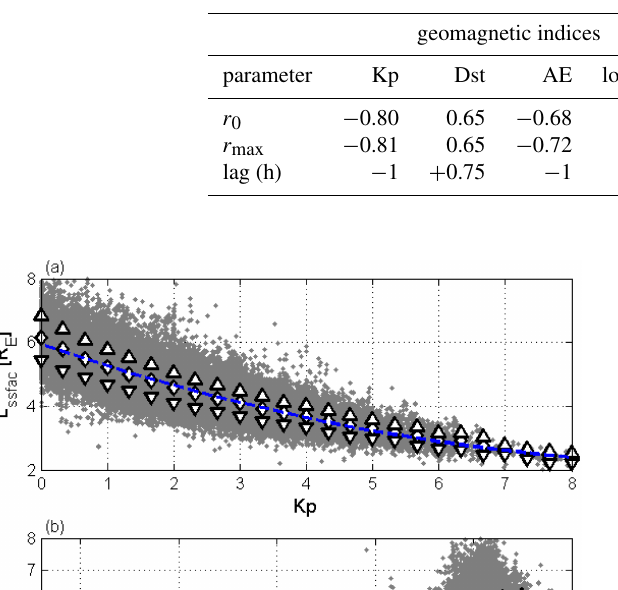
Table 2. Summary of cross-correlation analyses between the SSFAC index and the considered parameters.